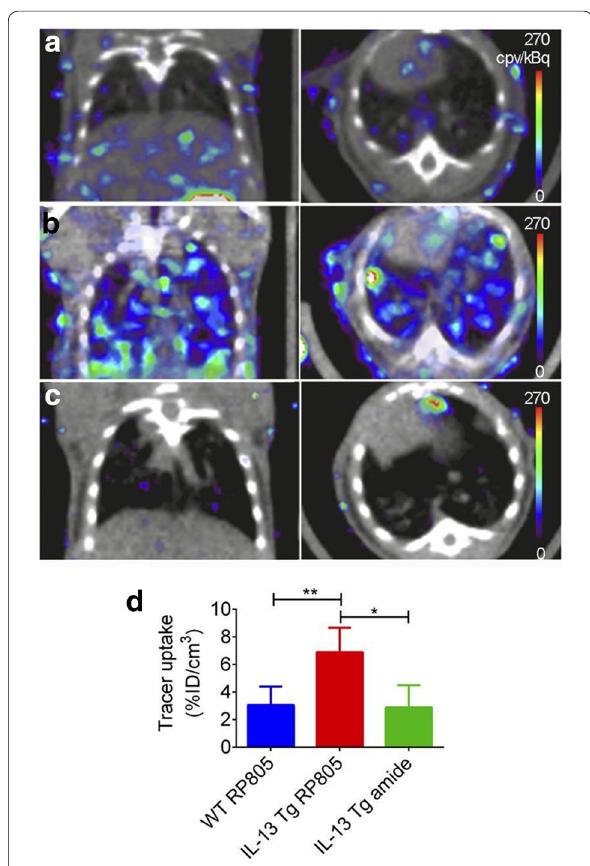
Fig. 4 In vivo small-animal SPECT/CT imaging of MMP activation. a – c Examples of coronal (left) and transversal (right) views of fused small-animal SPECT/CT images of WT mice injected with RP805 ( a ) and CC10-IL-13 Tg mice injected with RP805 ( b ) or its control, amide analog tracer ( c ). d Small-animal SPECT–derived quantification tracer uptake in lungs. N 5, 6, 13, and 5, respectively, for WT mice = injected with RP805 and CC10-IL-13 Tg mice injected with RP805 or amide, control analog. * P , 0.01. ** P , 0.001. cpv 5 counts per voxel; ID 5 injected dose. (This research was originally published in JNM [32]. © by the Society of Nuclear Medicine and Molecular Imaging,